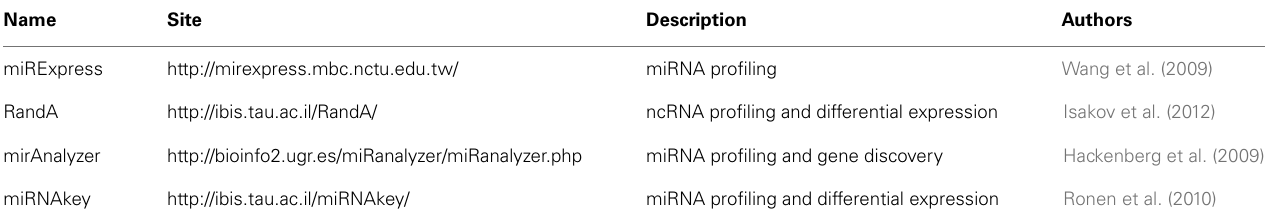
Table 4 | Pipelines for HTS analysis.